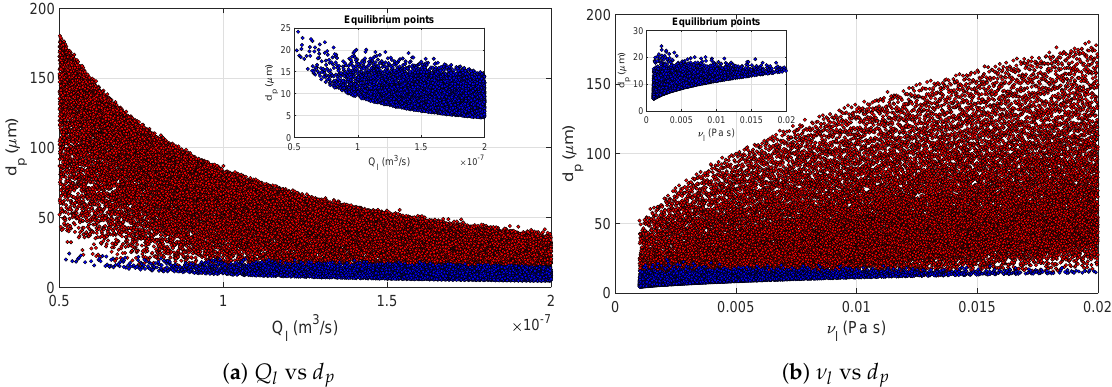
Figure 10. Scatter plots of final particle size d p with respect to feed flow rate Q l ( a ) and feed viscosity ν l ( b ). The red dots indicate the values at non-equilibrium conditions, while blue dots represent the values at equilibrium. The equilibrium points are also shown explicitly in the insets. Unlike the pneumatic nozzle, the pressure nozzle conditions also influence the equilibrium